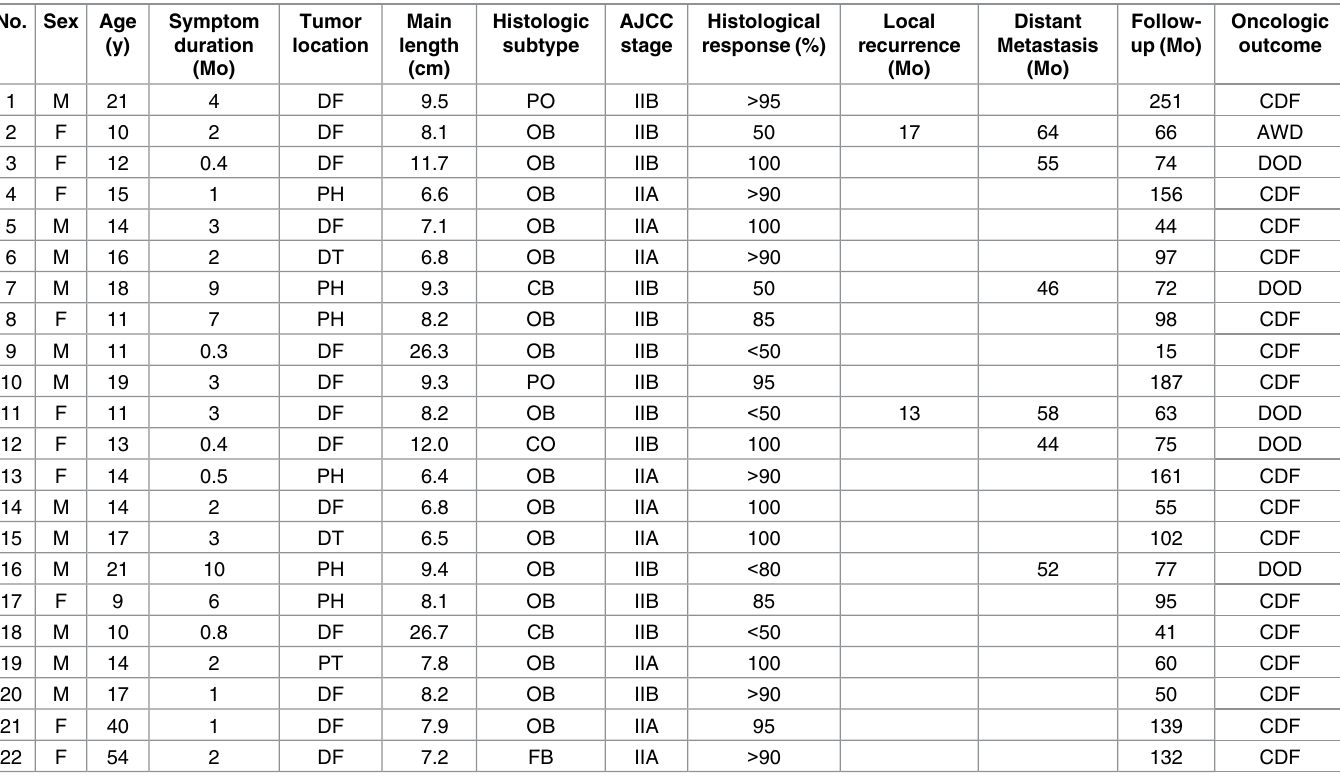
Table 1. Characteristics of patients.